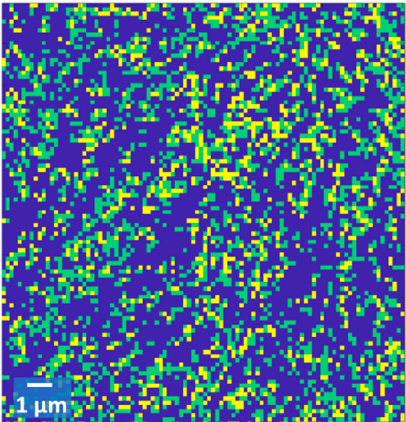
Figure 6. Color map representing the local area fraction of auto-tempered carbides in the sample. Apparent area fractions of auto-tempered carbides; >10% yellow, 1–10% green, and <1% blue.